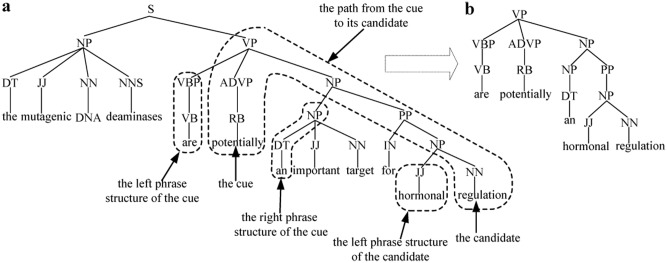
Phrase features extraction.(a) The phrase tree segment of sentence 1; (b) Phrase features.